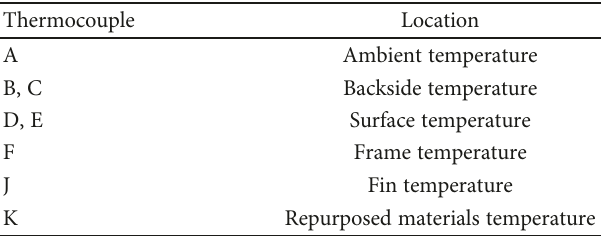
Figure 3: (a) Solar simulator, (b) PV panel used, (c) backside of the PV panel with paste for fi n installation, (d) installed perforated aluminium fi ns, and (e) PV analyser. Table 4: Distribution of